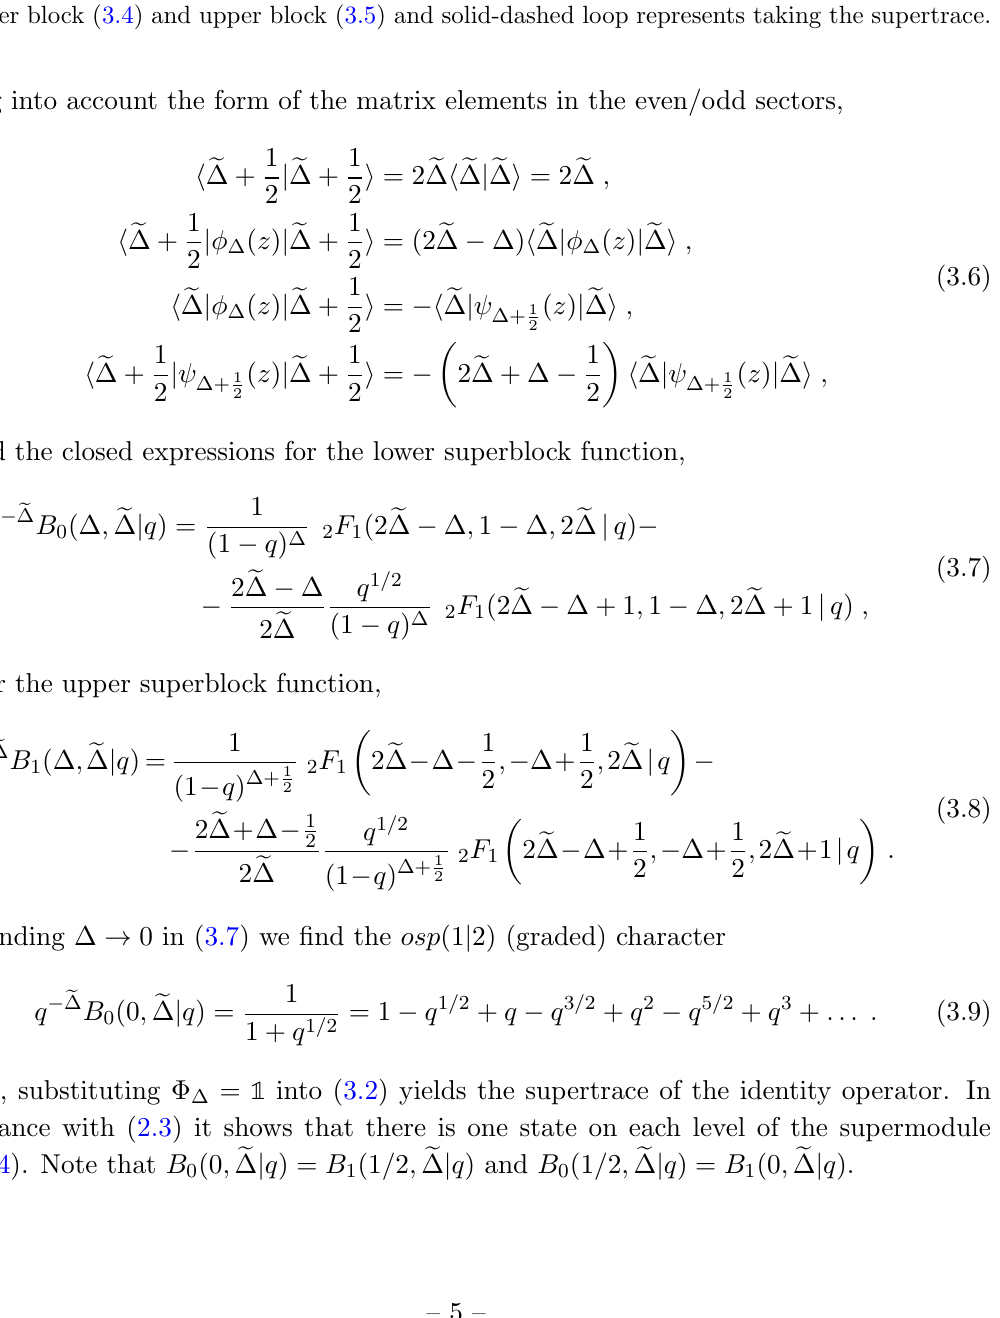
). The solid (dashed) (cid:1)+ 1 2